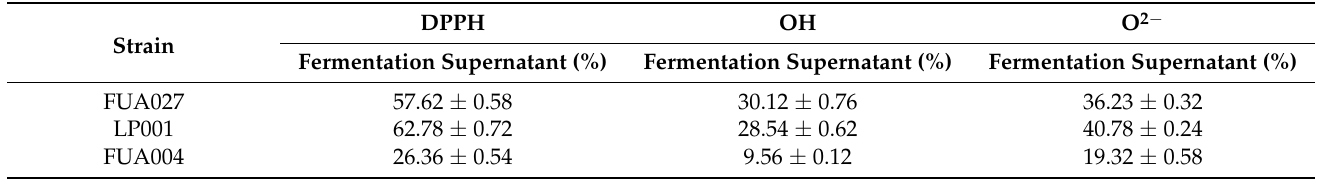
Table 4. Antioxidant activity of E. faecium FUA027 in vitro.